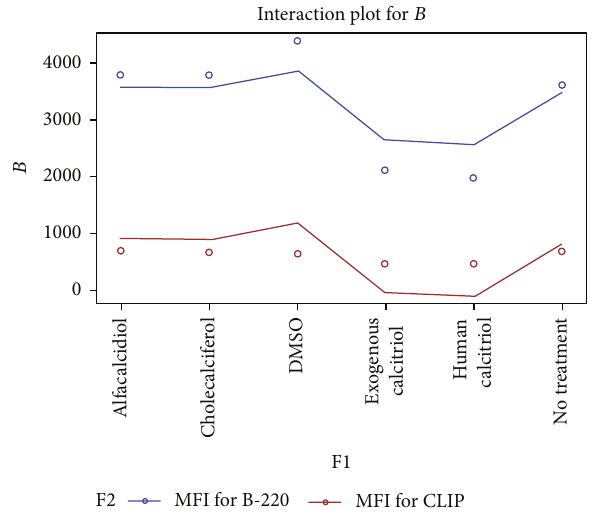
Figure 5: This figure compares the impact of the various vitamin D compounds at 1.0 mg/dL on the density of cell surface CLIP expression and B220 subsets of B cells 15hrs after treatment using the vitamin D3 compounds versus nontreatment or DMSO. These results suggest that the active formulation of vitamin D3 once again leads to a statistically significant reduction in CLIP expression on polyclonally activated splenic B cells even at a higher concentration of 10 mg/dL. Administration of the human calcitriol of vitamin D3 ( 𝑃 = 0.0181 ) resulted in the greatest overall reduction in the MFI (482.3 versus a baseline of 701.1 and 667.7 for the control) of CLIP expression on mitogen stimulated B cells.